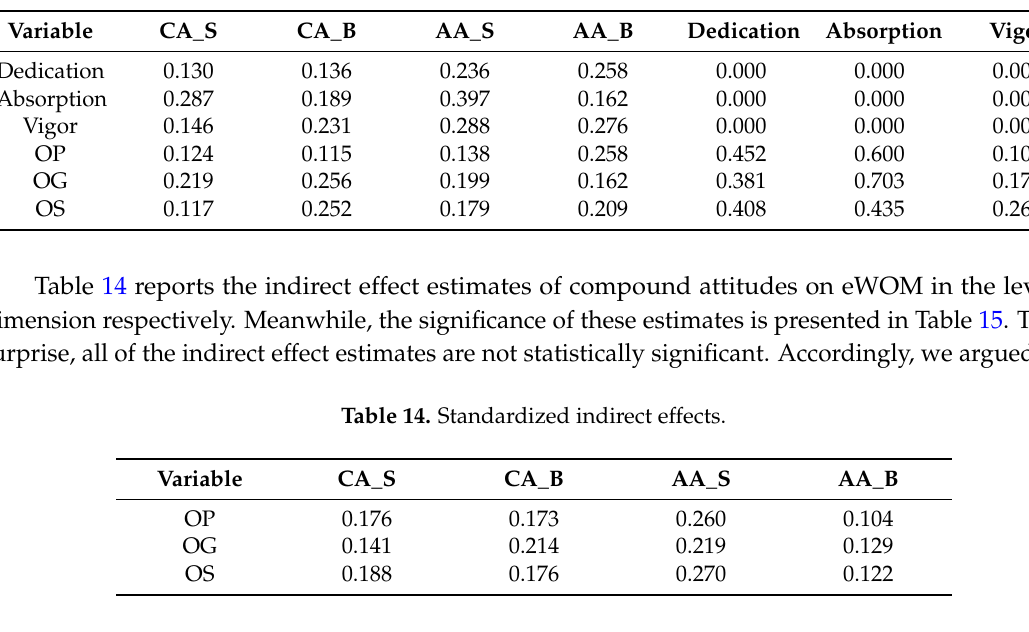
Table 15. Standardized indirect effects—two tailed significance